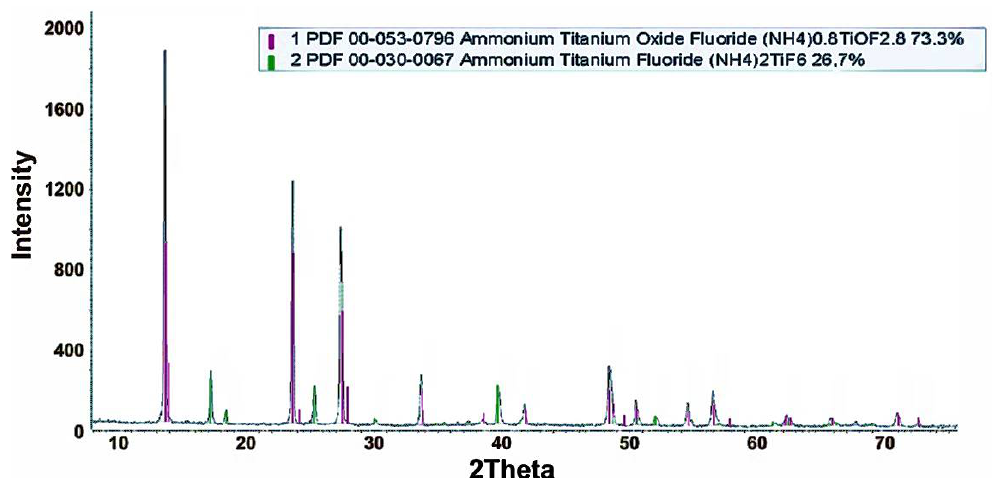
Figure 2. XRD pattern of the original sample of titanium fluorides.